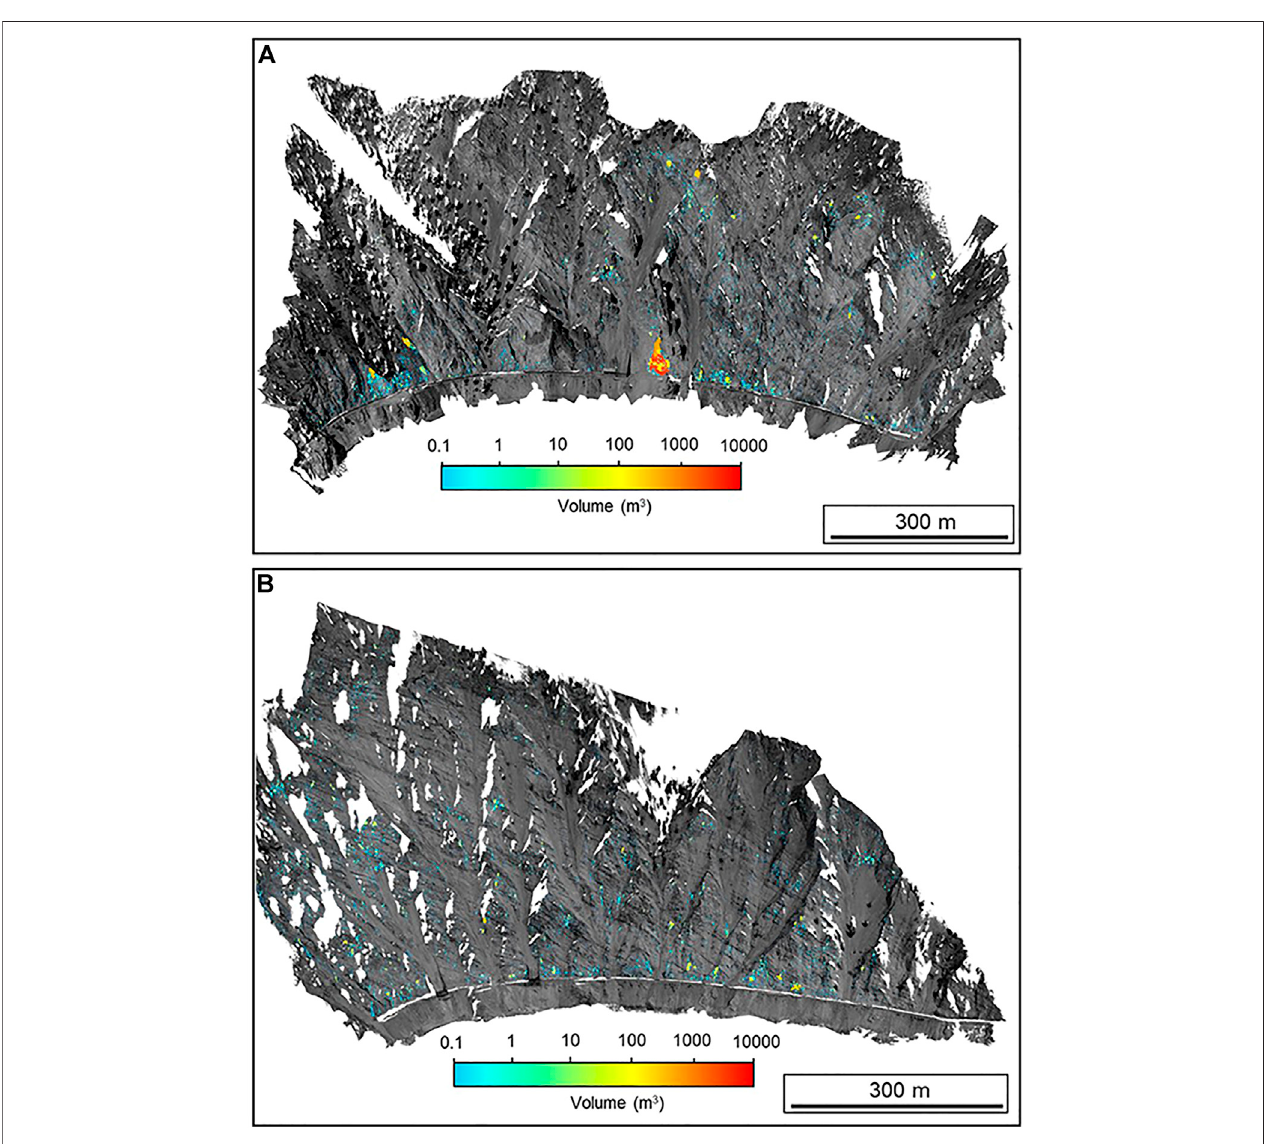
FIGURE9| Detected rockfallevents thatoccurredinthe WhiteCanyonbetweenApril 2013andMarch 2020. Thecolorscalecorresponds tothemagnitude ofthe rockfall. The lower limit of 0.1 m 3 was established as the lowest event visible from this scale of visualization. (A) WCW and (B) WCE. Modi fi ed from DiFrancesco et al.